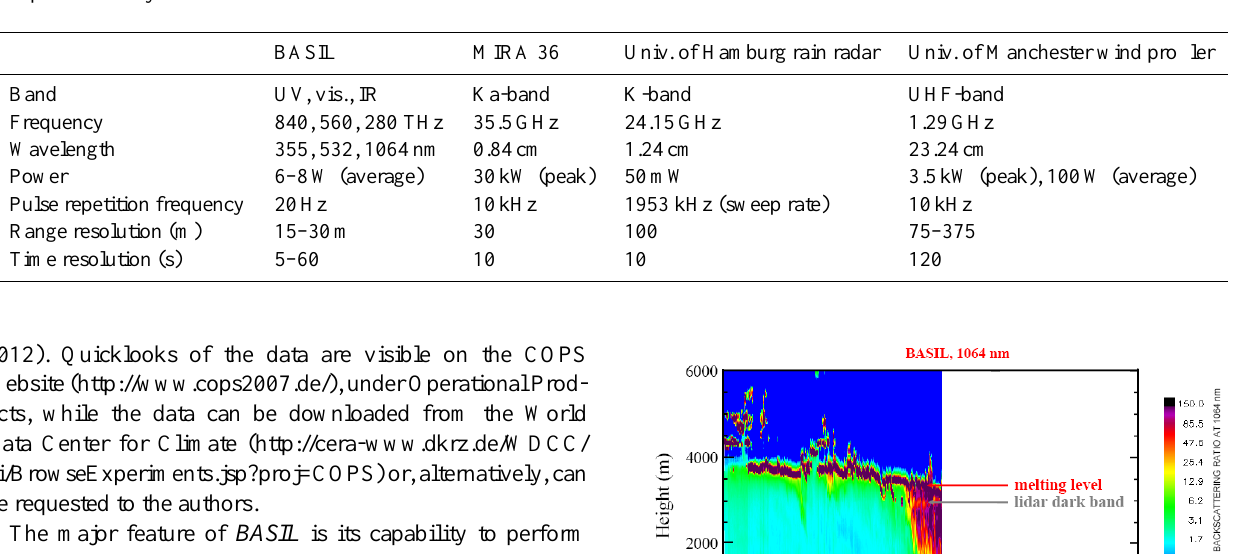
Table 1. Specifications of the Raman lidar and the three radars deployed in Achern during the Convective and Orographically-induced Precipitation Study.